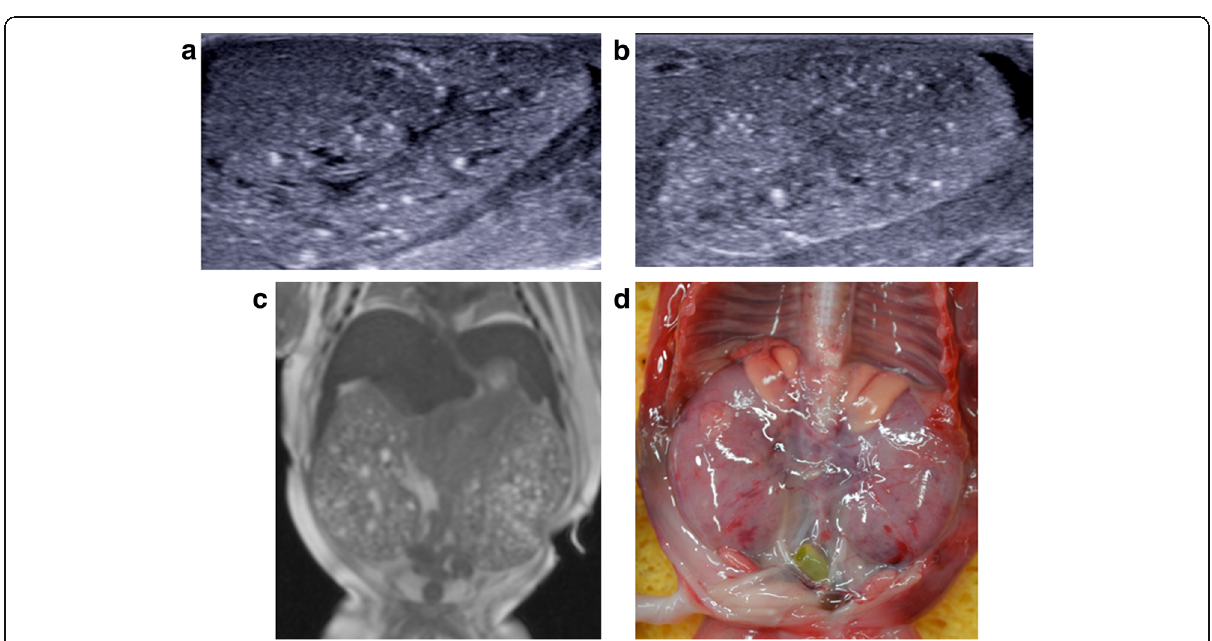
Fig. 20 a – c Autosomal recessive polycystic kidney disease in a foetus at 17weeks gestation, following termination of pregnancy. The post-mortem imaging was obtained 8days after delivery. The sagittal post-mortem ultrasound images of the right ( a ) and left ( b ) kidneys demonstrate poor corticomedullary differentiation, numerous hyperechoic foci and a hyperechoic renal cortex in keeping with numerous renal microcysts. The corresponding post-mortem T2 weighted MRI in coronal plane ( c ), also shows enlarged kidneys with small microcysts and a normal appearing liver. At autopsy, the photograph taken of the retroperitoneum, with both kidneys in situ ( d ), shows the large size of these organs, occupying almost the entire